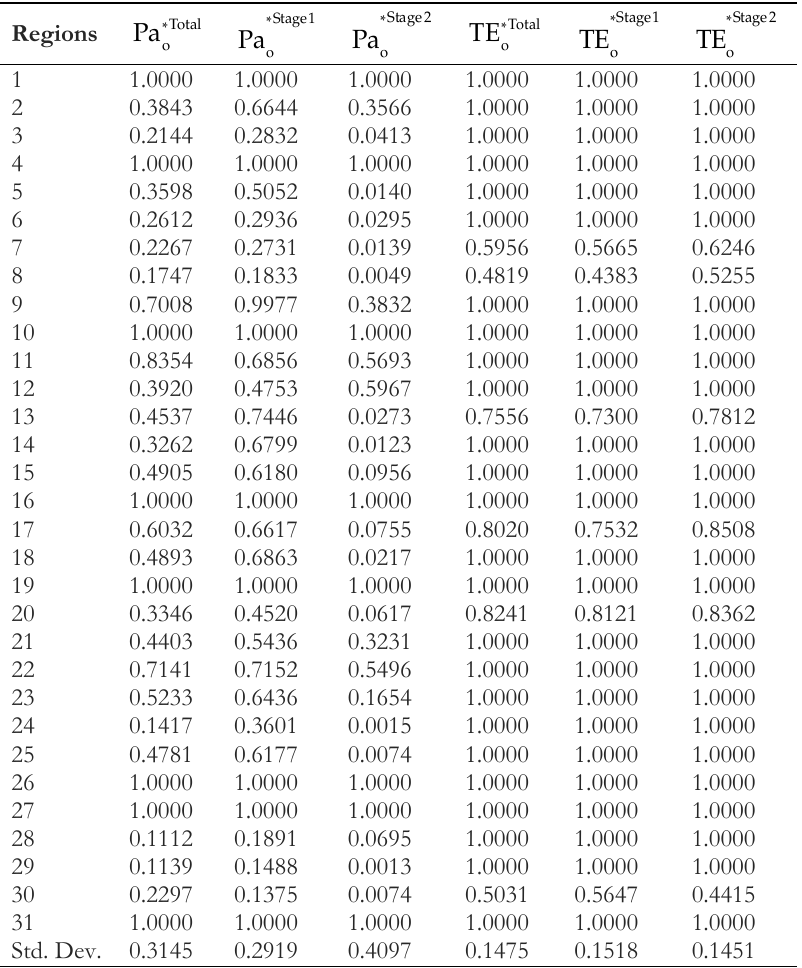
Table 3. Profitabilty and technical efficiency of two-stage feedback